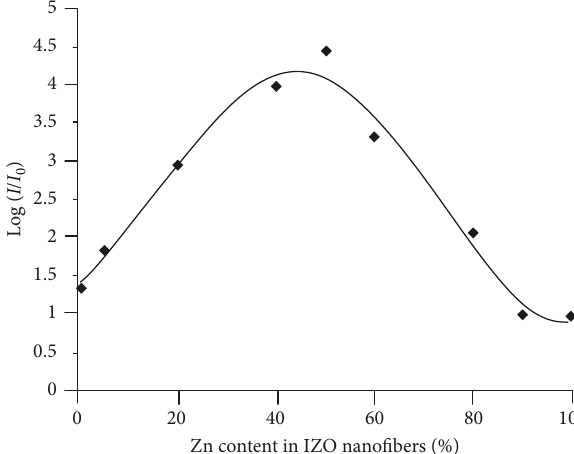
Figure 6: UV sensitivity of IZO nanofibers as a function of zinc 2 O 3 ), IZO5 (InZn